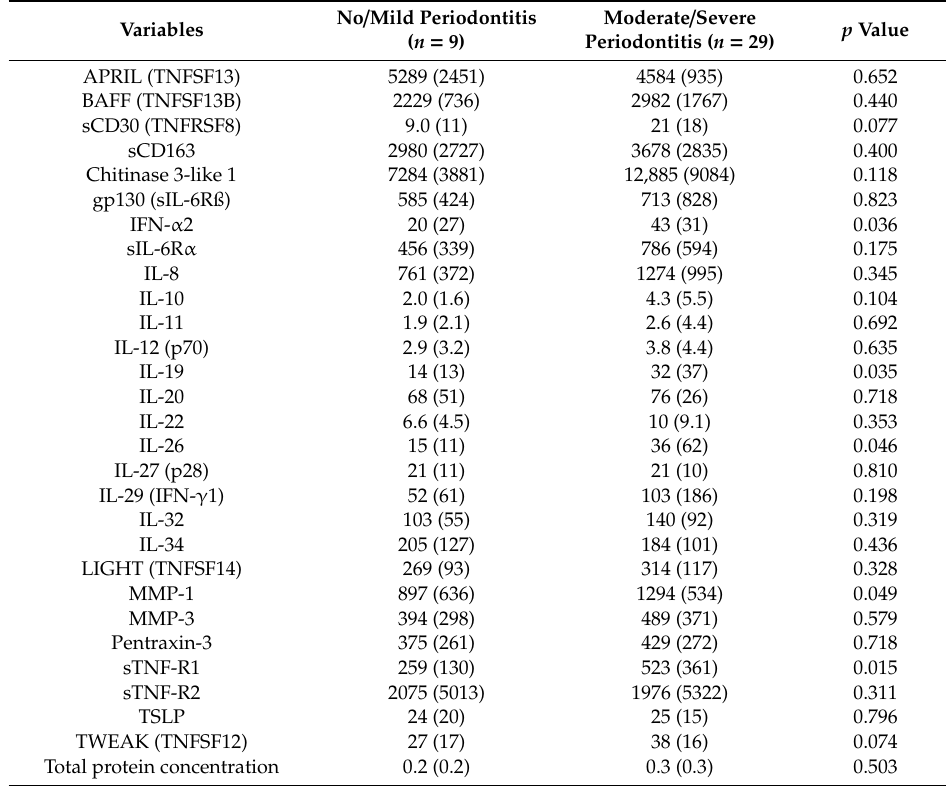
Table 3. Levels of inflammatory mediators (mean ± SD) and total protein (mg / mL) in gingival crevicular fluid (GCF) of subjects with RA in relation to periodontal